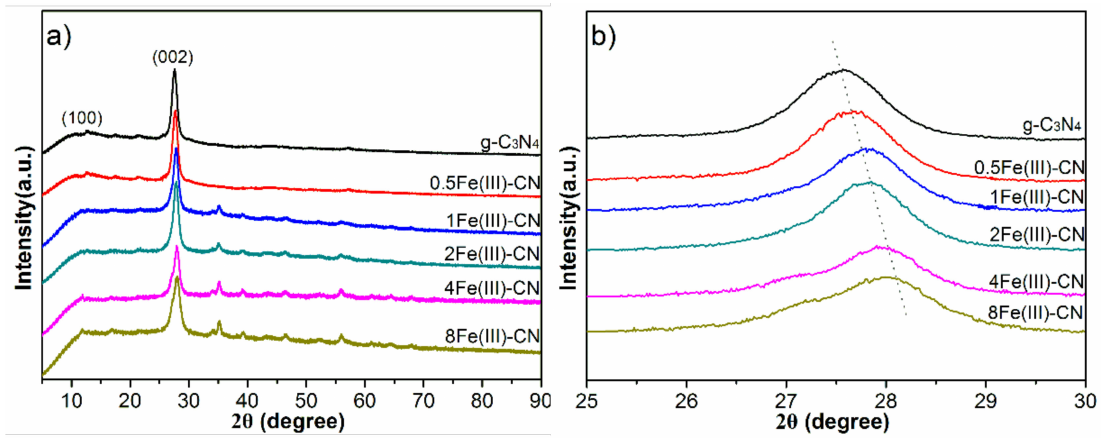
Figure 1. XRD patterns of all samples: 5 ◦ –90 ◦ ( a ); 25 ◦ –30 ◦ ( b